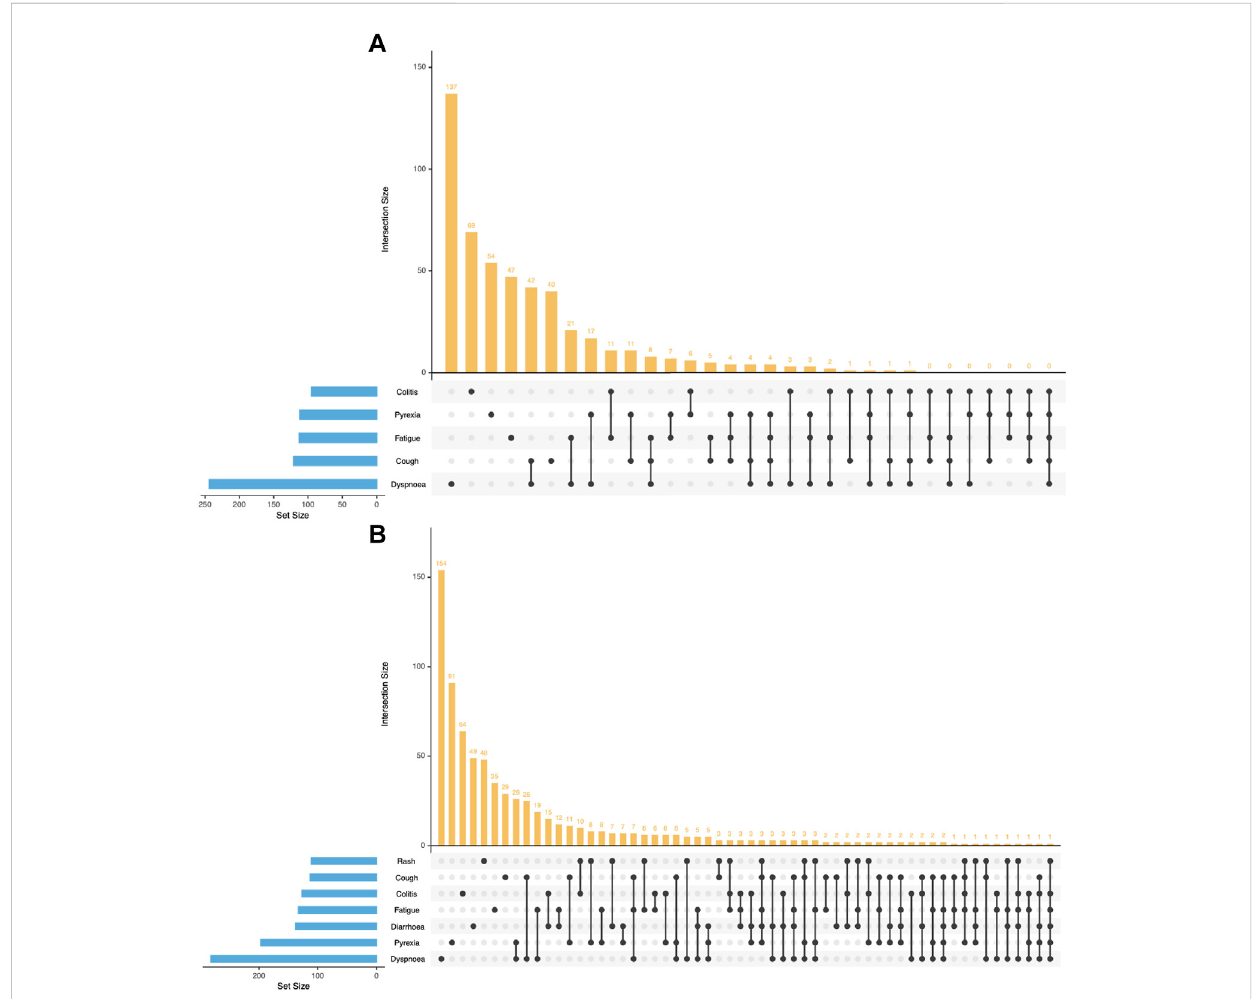
FIGURE 2 UpSetPlotdepictingtop5concomitanttoxicitiesalongwithpneumonitisinVigiBaseandtop7concomitanttoxicitieswithFAERSdatabases. (A) data from the VigiBase database. (B) data from the FAERS